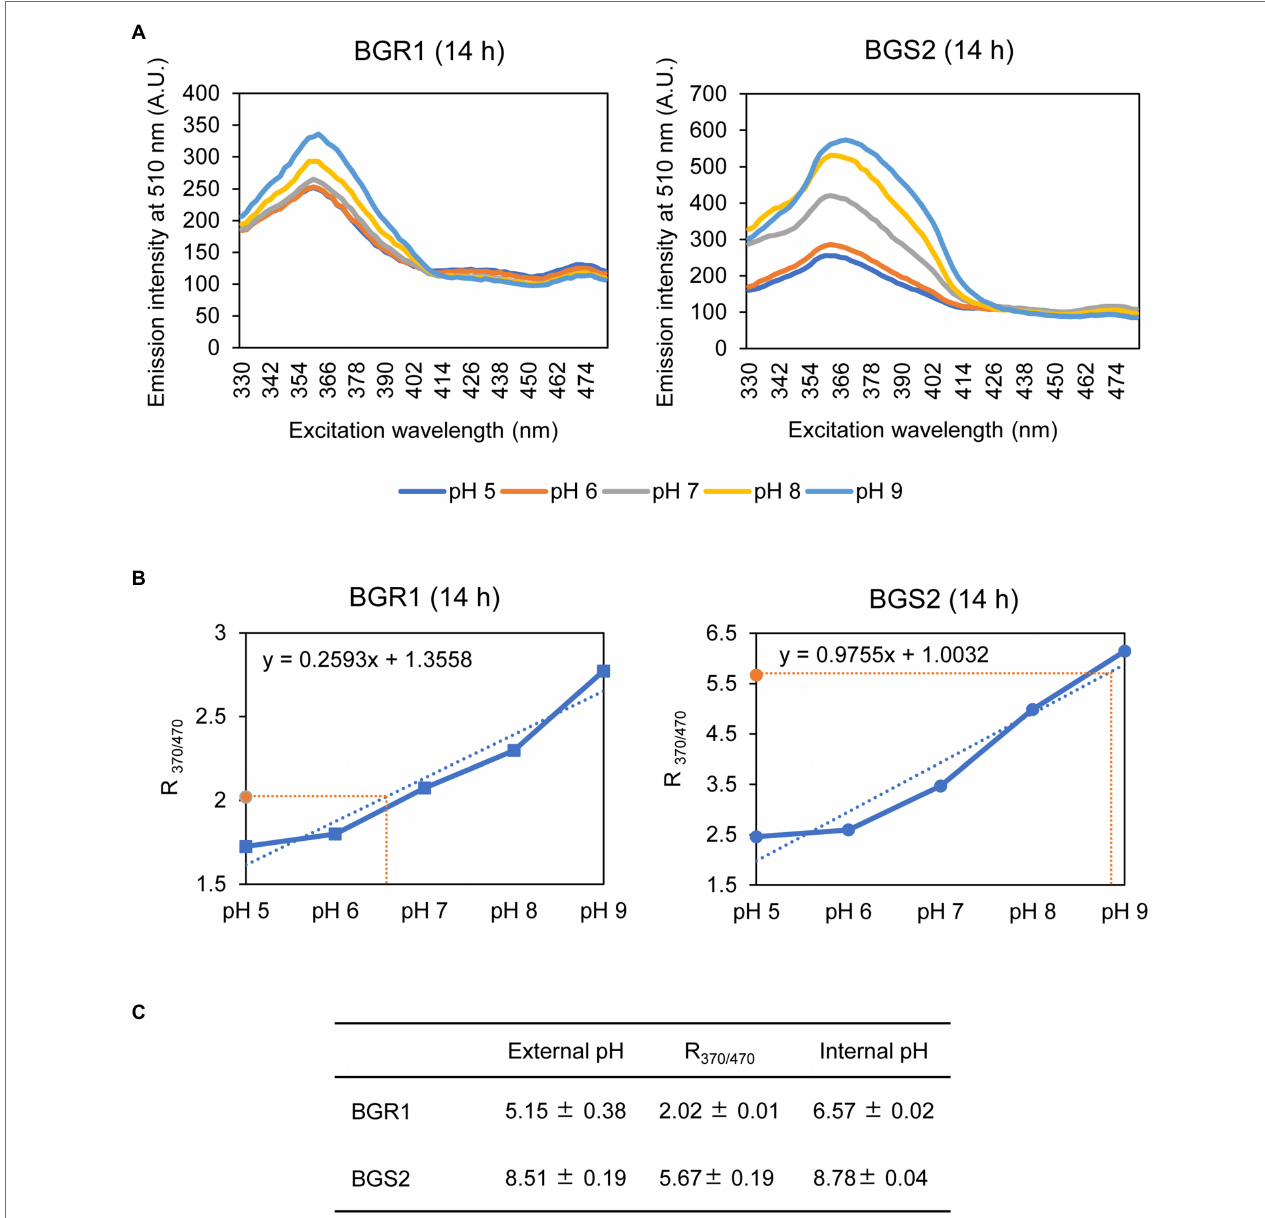
FIGURE 7 | Measurement of the internal pH of wild-type BGR1 and BGS2 (BGR1 tofI :: Ω ). (A) Fluorescence excitation spectrum of the ratiometric fluorescent indicator pHluorin for wild-type BGR1 and BGS2 (330–482 nm; emission, 510 nm). Wild-type BGR1 and BGS2 (BGR1 tofI :: Ω ) were grown in LB broth for 14 h at 37 ° C. Subsequently, the cells were resuspended in DPBS at different pH (pH 5, 6, 7, 8, or 9) in the presence of 40 mM potassium benzoate and 40 mM methylamine hydrochloride to collapse the transmembrane pH gradient. The fluorescence intensity was measured using a microplate reader, and the mean values obtained from three independent experiments are shown. AU, arbitrary units. (B) Calibration curves for wild-type BGR1 and BGS2 (BGR1 tofI :: Ω ) for measuring internal pH. The data for the calibration curves were obtained as ratios (R 370/470 ), and the curves were used to determine internal pH. (C) External pH, R 370/470 , and internal pH of wild- type BGR1 and BGS2 (BGR1 tofI :: Ω ) after 14 h in LB broth at 37 ° C. Data are mean ± SE of triplicate